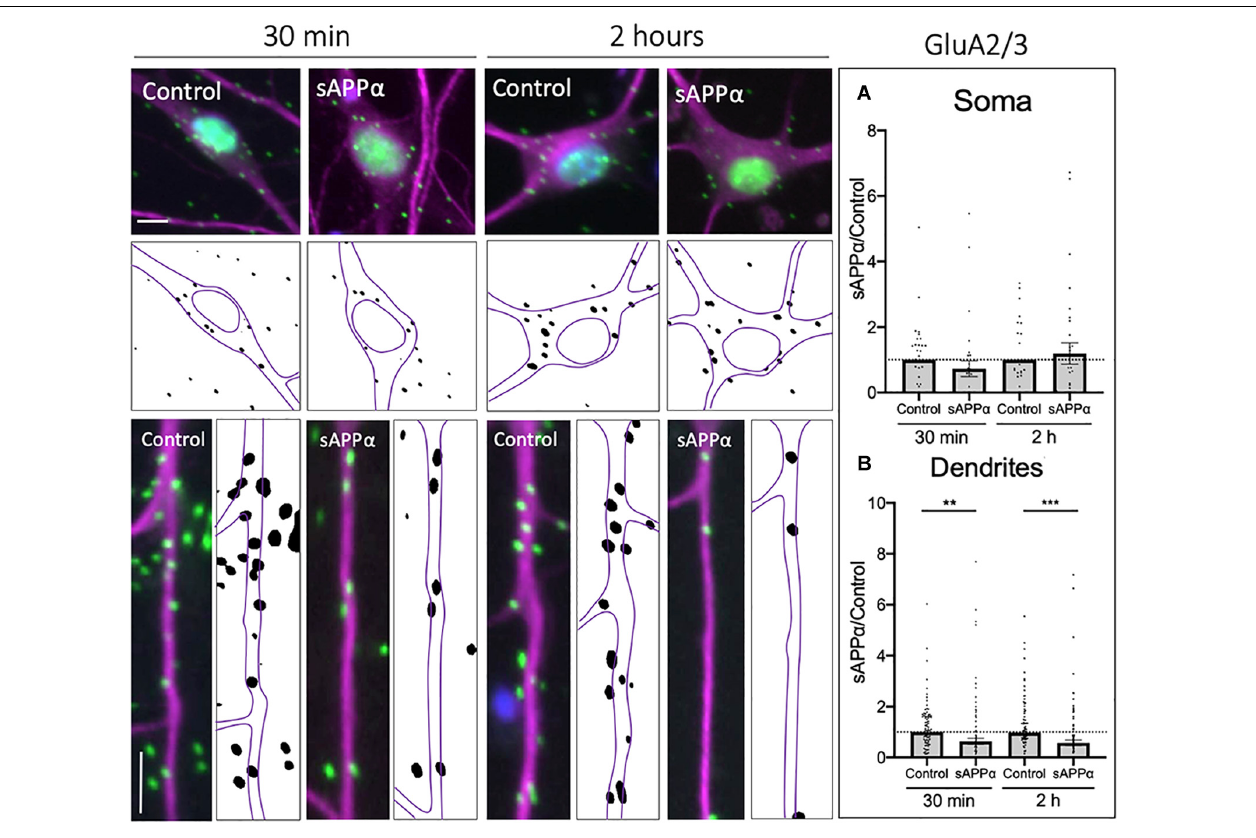
FIGURE 8 | Secreted amyloid precursor protein-alpha downregulates cell-surface GluA2/3-containing AMPAR expression. Representative images showing cell-surface GluA2/3 levels in the soma (top panels) and dendrites (lower panels) from 30 min (left) and 2 h (right) controls and sAPP α treated conditions. (A) Average data showing sAPP α (1 nM) does not affect somatic GluA2/3 following 30- and 2 h treatments ( n = 30–32 cells). (B) Average data showing sAPP α (1 nM; 30 min, 2 h) promotes a decrease in the dendrites ( n = 109–111). All data are expressed relative to control, as mean ± SEM from 3 experiments. Normality was detected by D’Agostino and Pearson omnibus normality tests and significance was assessed by student’s t -test, ** p = 0.0033, *** p = 0.0002. Representative images show neuronal soma (upper panels) and dendrites (lower panels; MAP2, (cid:4) , GluA2/3, (cid:4) ; DAPI, (cid:4) ). Scale bars = 10 µ